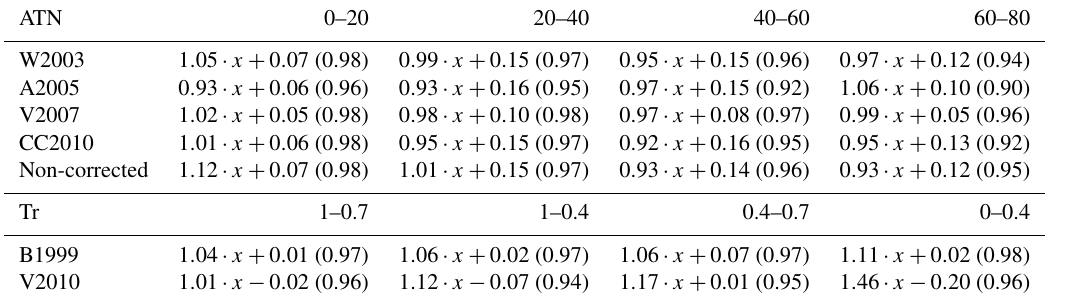
Table 3. Linear fits between the AE31 and reference absorption ( σ abs , ref measured by the MAAP) for different ATN intervals (at 660nm) as well as between the PSAP and σ abs , ref . The value in parentheses is the coefficient of determination ( R 2 ).